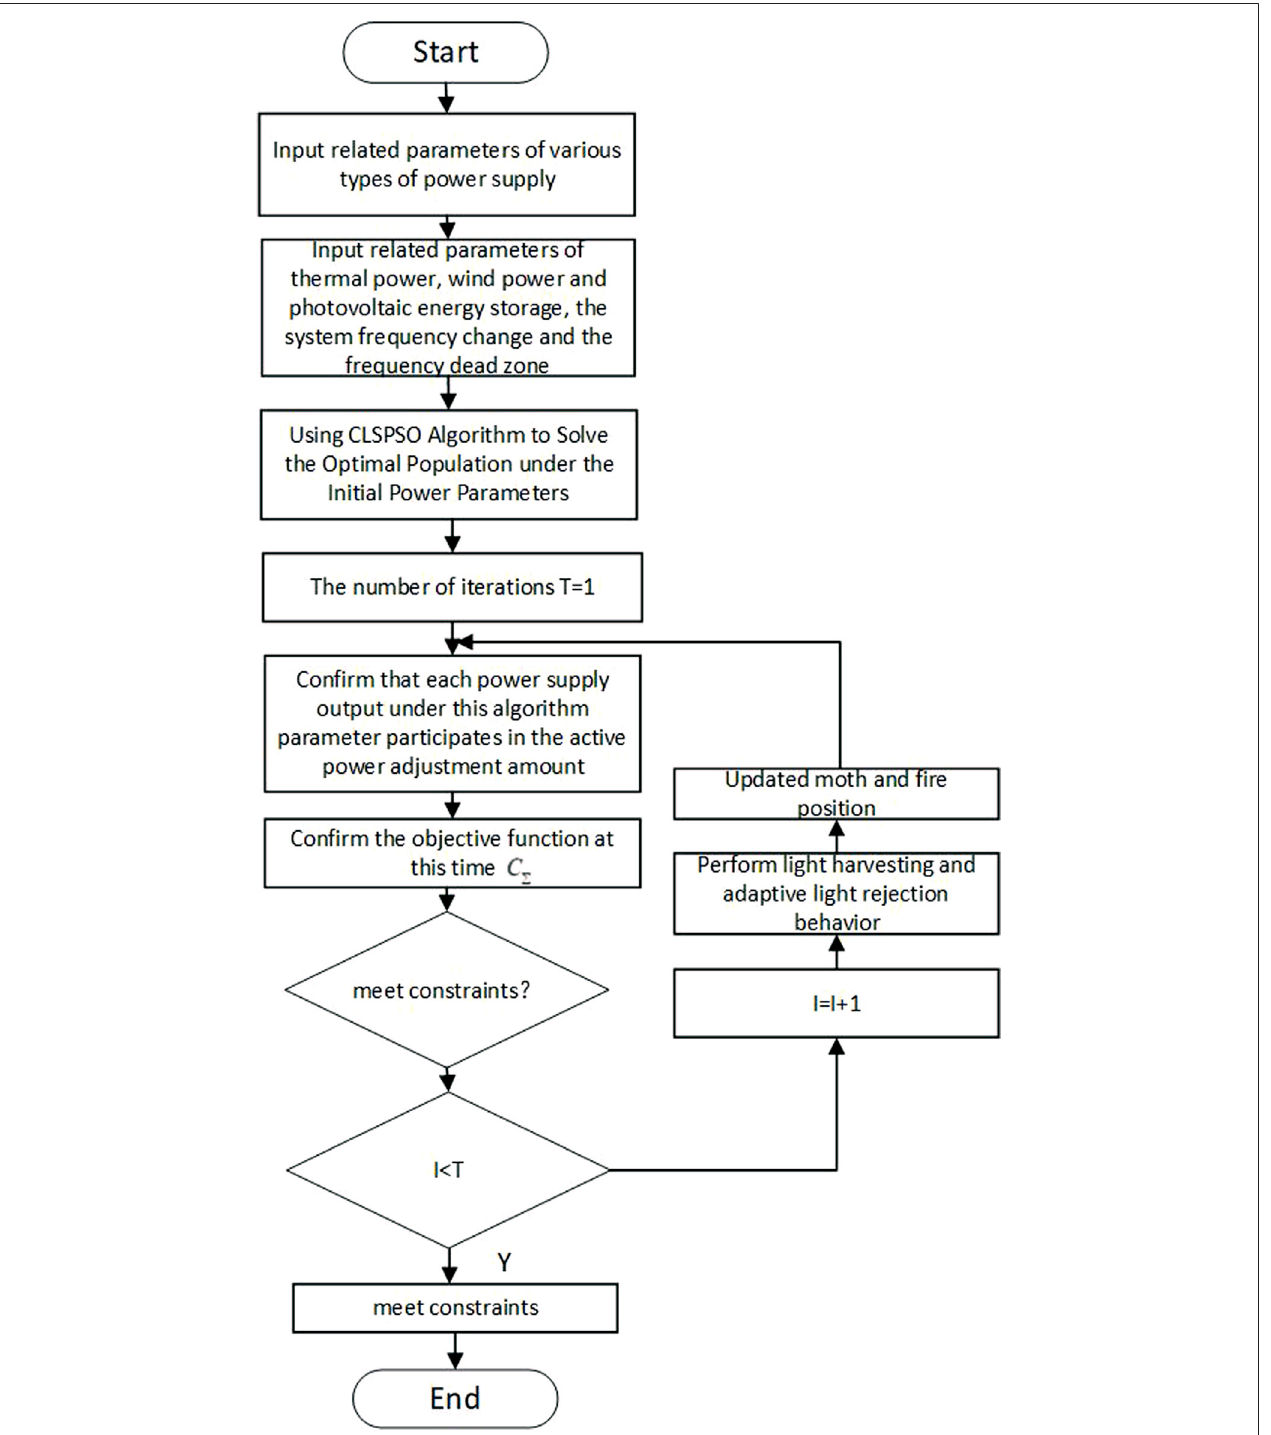
FIGURE 3 | Algorithm fl ow